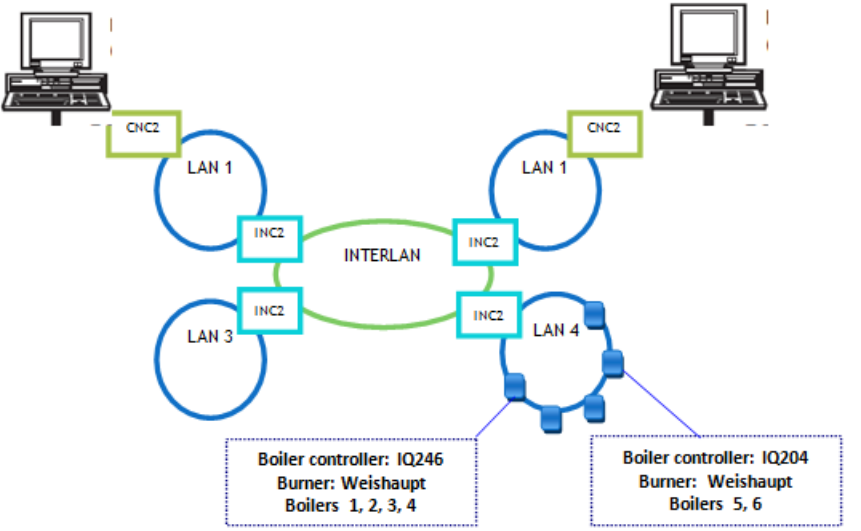
Figure 4. The architecture of the hospital